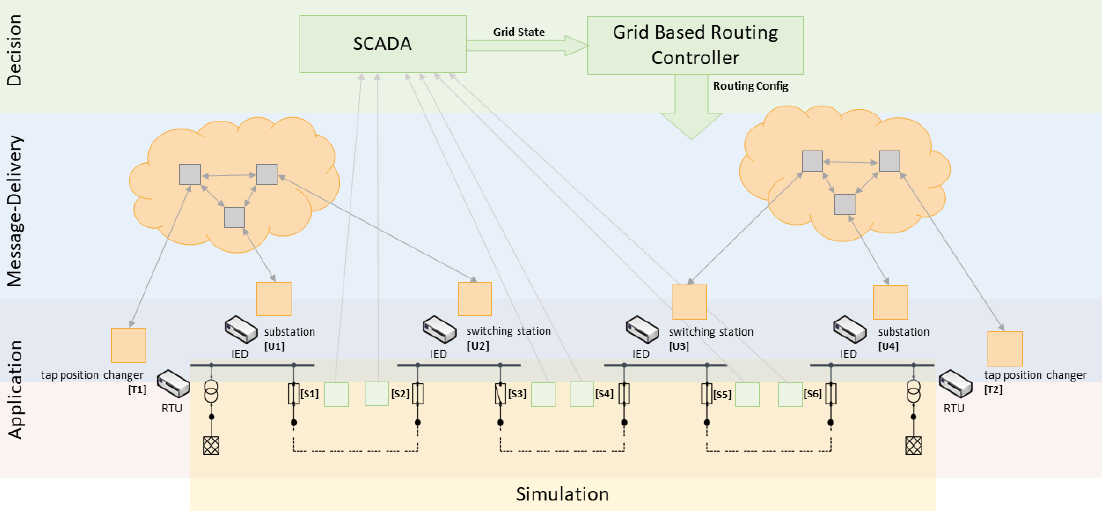
Figure 6. Architecture: Mapping of the top level